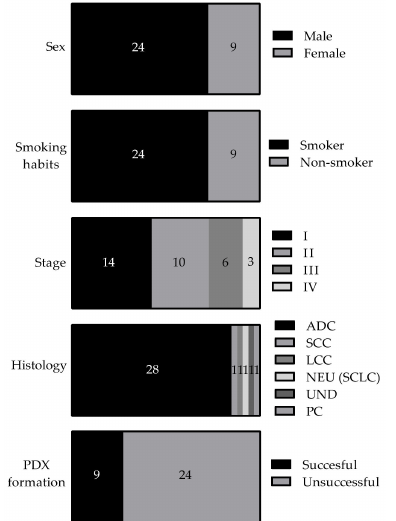
Figure 1. Clinicopathological characteristics of patients. ADC, smokers or ex-smokers, and males are more represented in our study. ADC: adenocarcinoma; SCC: squamous-cell carcinoma; LCC: large-cell lung carcinoma; NEU: neuroendocrine carcinoma; SCLC: small-cell lung cancer; UND: undifferentiated tumor; PC: pulmonary pleomorphic carcinoma; PDX: patient-derived